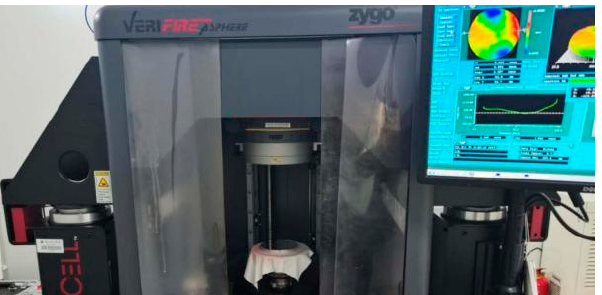
Figure 3. Six-inch aspheric vertical interferometer of Zygo VerFire Asphere.